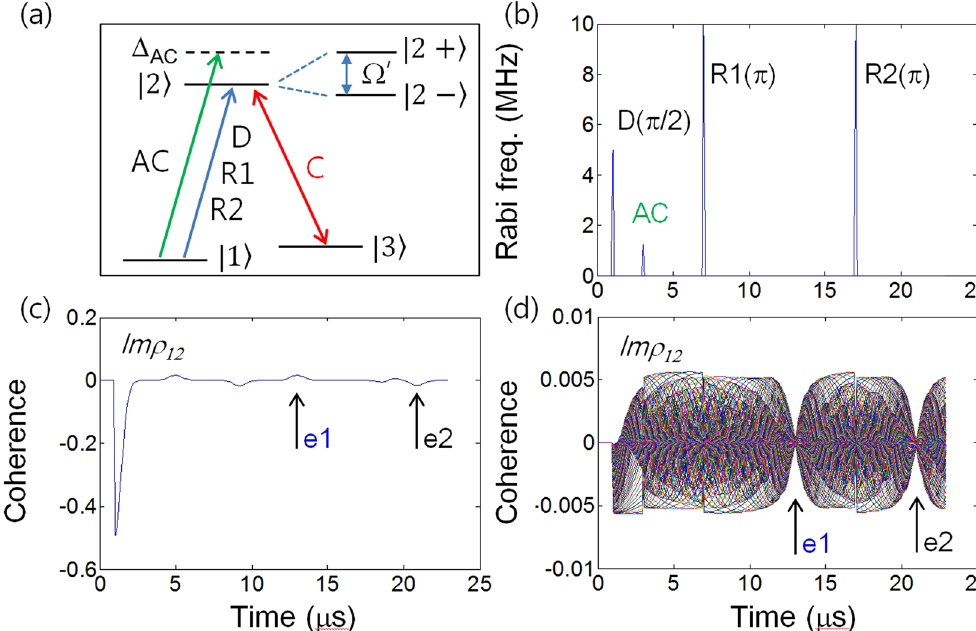
Figure 1. Echo erasing by ac Stark shift. ( a ) Energy level diagram for ac Stark modulation: ac Stark (AC), Data (D), Rephasing (R1), and Rephasing (R2). The control pulse C and state 3 are for CASE (discussed in Section D). ( b ) Pulse sequence for ( a ). ( c ) Numerical results of echo erasing (silence) for a π /2 pulse area of ac Stark field AC. ( d ) Individual atom coherence of ( c ). For this the optical inhomogeneous broadening of the two-level system is 1.7 MHz (FWHM) and is divided into 201 groups of atoms at 10 kHz spacing for individual calculations. All decay rates are set to zero. Initially, all atoms are in the ground state: ρ 11 (0) = 1. Each pulse duration is set to 0.1 μ s. The time of arrival of D, AC, R1 and R2 are 1, 3, 7, and 17 μ s, respectively. The AC Rabi frequency is Ω AC = 1.25 MHz, and its detuning is Δ AC = Ω 15 . The ac Stark shift Δ S is replaced by the AC 2 2 . This replacement does not alter the ac Stark generalized Rabi frequency of the ac Stark field Ω′ = ∆ + Ω AC AC physics but accelerates the phase shift time. The e1 is the target echo for erasing. All frequency parameters are multiplied by 2 π for all figures. AC field in ( a ) dresses both ground and excited states in the same way, where the ground state splitting is omitted for simplicity 28 .